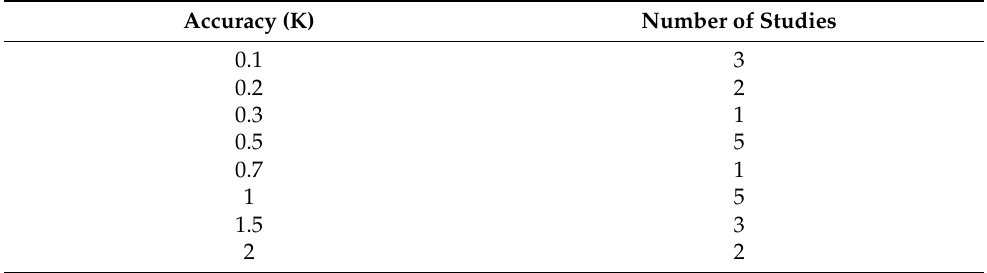
Table 6. Number of studies by the accuracy of the achieved test temperatures (the difference between temperatures programmed and actual temperatures achieved), for the studies that give this